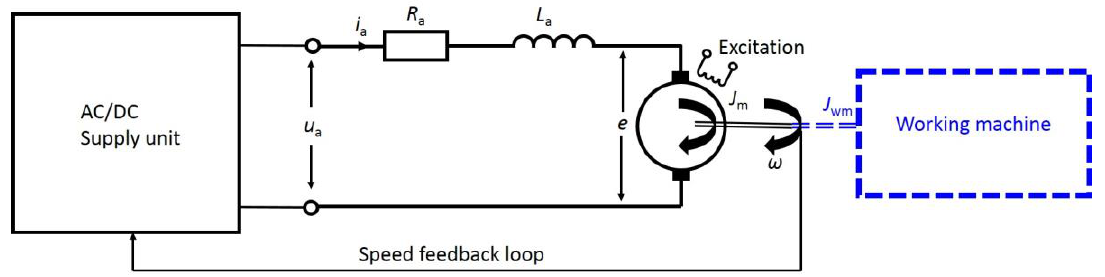
Figure 3. Schematic presentation of the drive composed of a controlled drive.